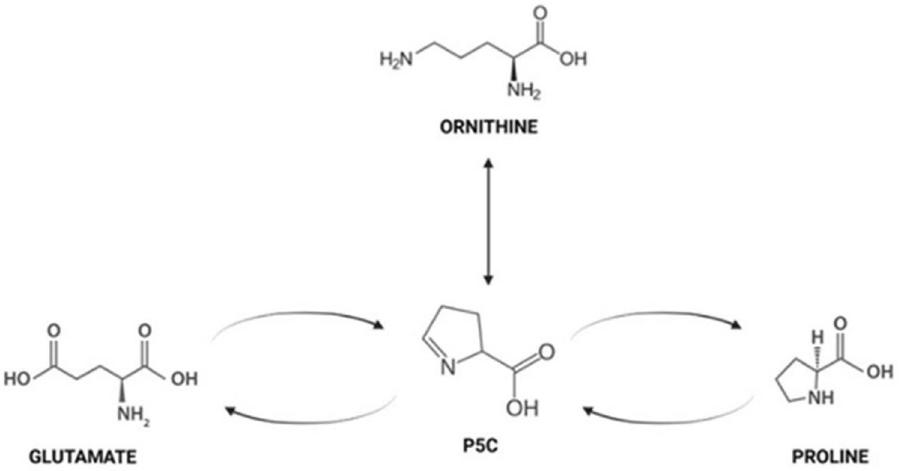
Figure 5. P5C cycle: Interconversion of proline to glutamate and ornithine; (P5C) pyr-roline-5-carboxylate. Figure was carried out by using BioRender (http:// biore nder.